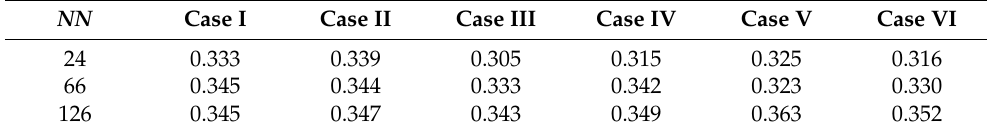
Table 11. The values of MAPE learn for different NN